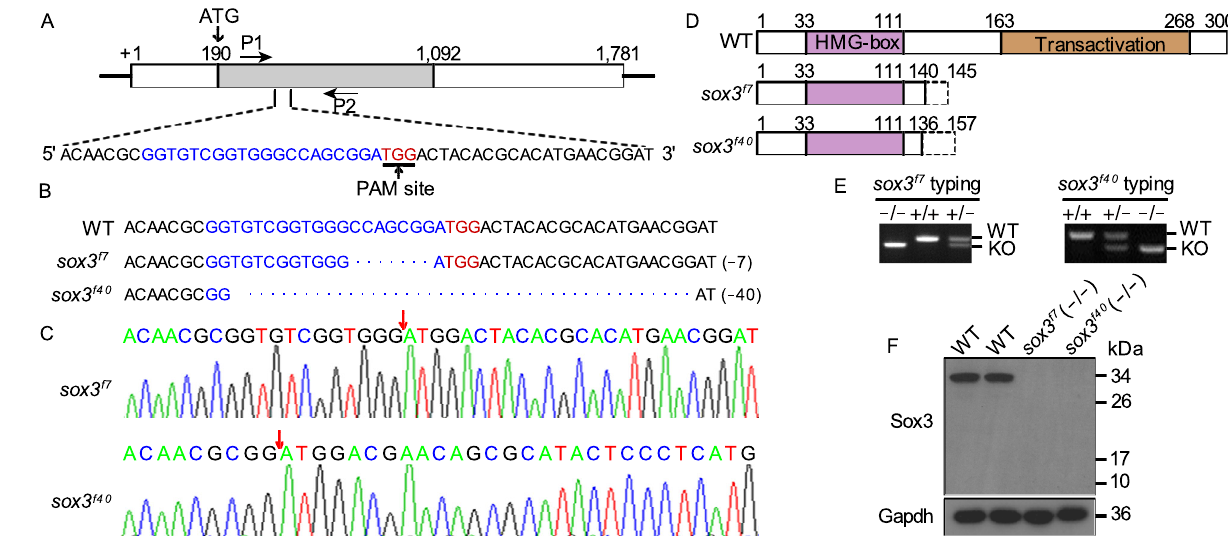
Figure 1. Generation of sox3 mutant strains of zebra fi sh using CRISPR/Cas9 system. (A) Schematic representation of gRNA targeting the sox3 locus. The translation start codon ATG was indicated by an arrow. The gRNA (blue) was designed to target open reading frame (ORF) (gray). The PAM (protospacer adjacent motif) site was underlined in red. P1 and P2 were primers for genotyping. (B) Nucleotide sequence alignments of the two mutant sites ( sox3 f7 and sox3 f40 ) with WT sequence. The deleted sequences were indicated in dotted lines. One had a 7-bp deletion, the other had a 40-bp deletion. (C) DNA sequencing of sox3 mutant alleles of both sox3 f7 and sox3 f40 strains. The red arrows indicated the deleted positions. (D) Schematic diagram of protein coding regions of wide type Sox3 and two predicted truncated mutants. The conserved domains (HMG-box and transactivation) were indicated in boxes (solid lines). Frameshift sequences were showed in boxes with dash lines. The numbers refer to the amino acid positions. (E) PCR analysis to determine genotypes of offsprings from heterozygote intercrosses in two KO strains. The KO band (287 bp of sox3 f7 and 254 bp of sox3 f40 ) can be distinguished from WT band (294 bp). Primer sequences and PCR conditions were listed in Table S1. (F) Western blot analysis of Sox3 expression. Ovary extracts from adult zebra fi sh were subjected to Western blots to detect Sox3 expression. The band of Sox3 protein was present in 33 kDa in WT zebra fi sh. Gapdh was used as an internal